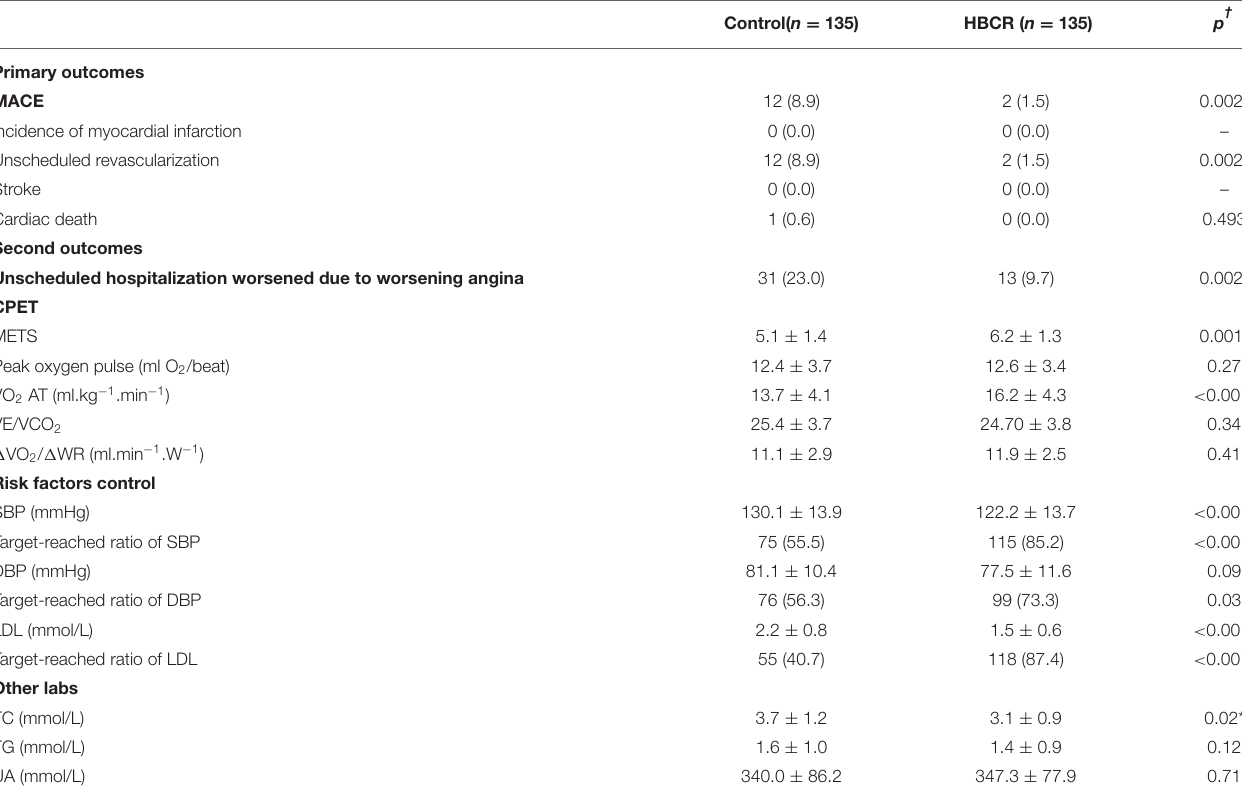
TABLE 2 | Summary statistics of the Home-Based Cardiac Rehabilitation program on primary and second outcomes at end of follow-up period for matched case and control.